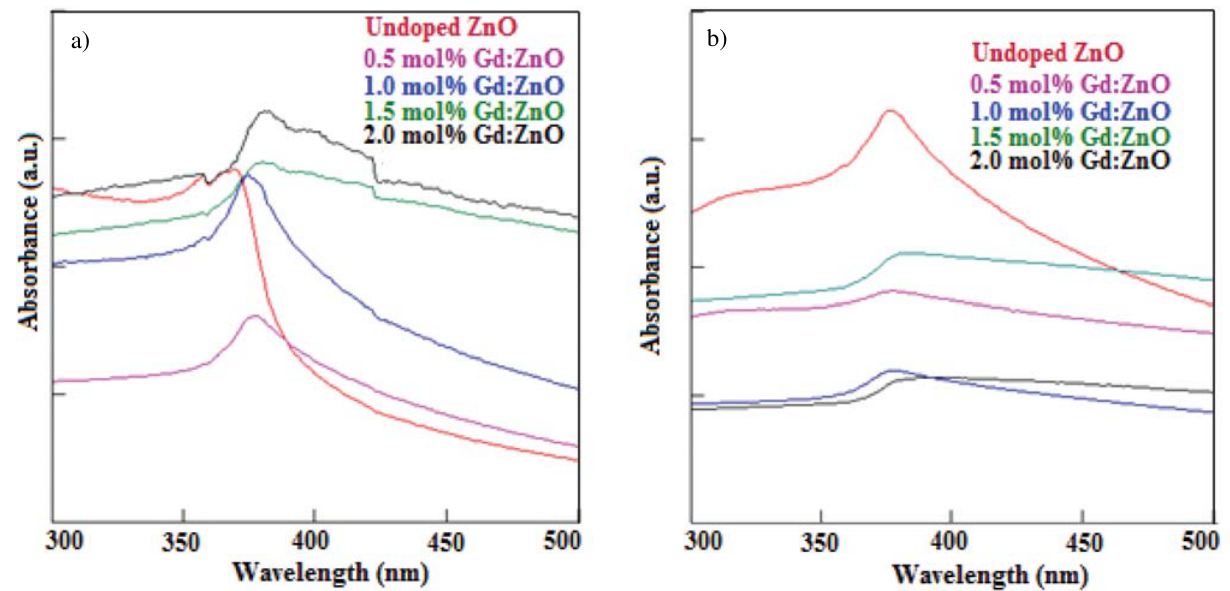
Figure 8. UV- Vis spectra of undoped and Gd doped ZnO nanoparticles synthesized using (a) CTAB and (b) PVP.